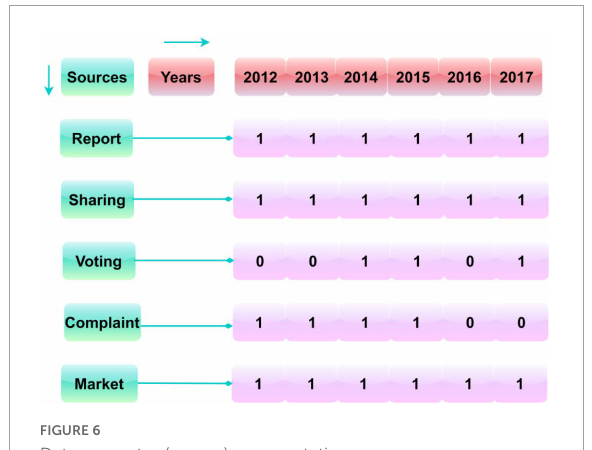
FIGURE6 Data generator (source)